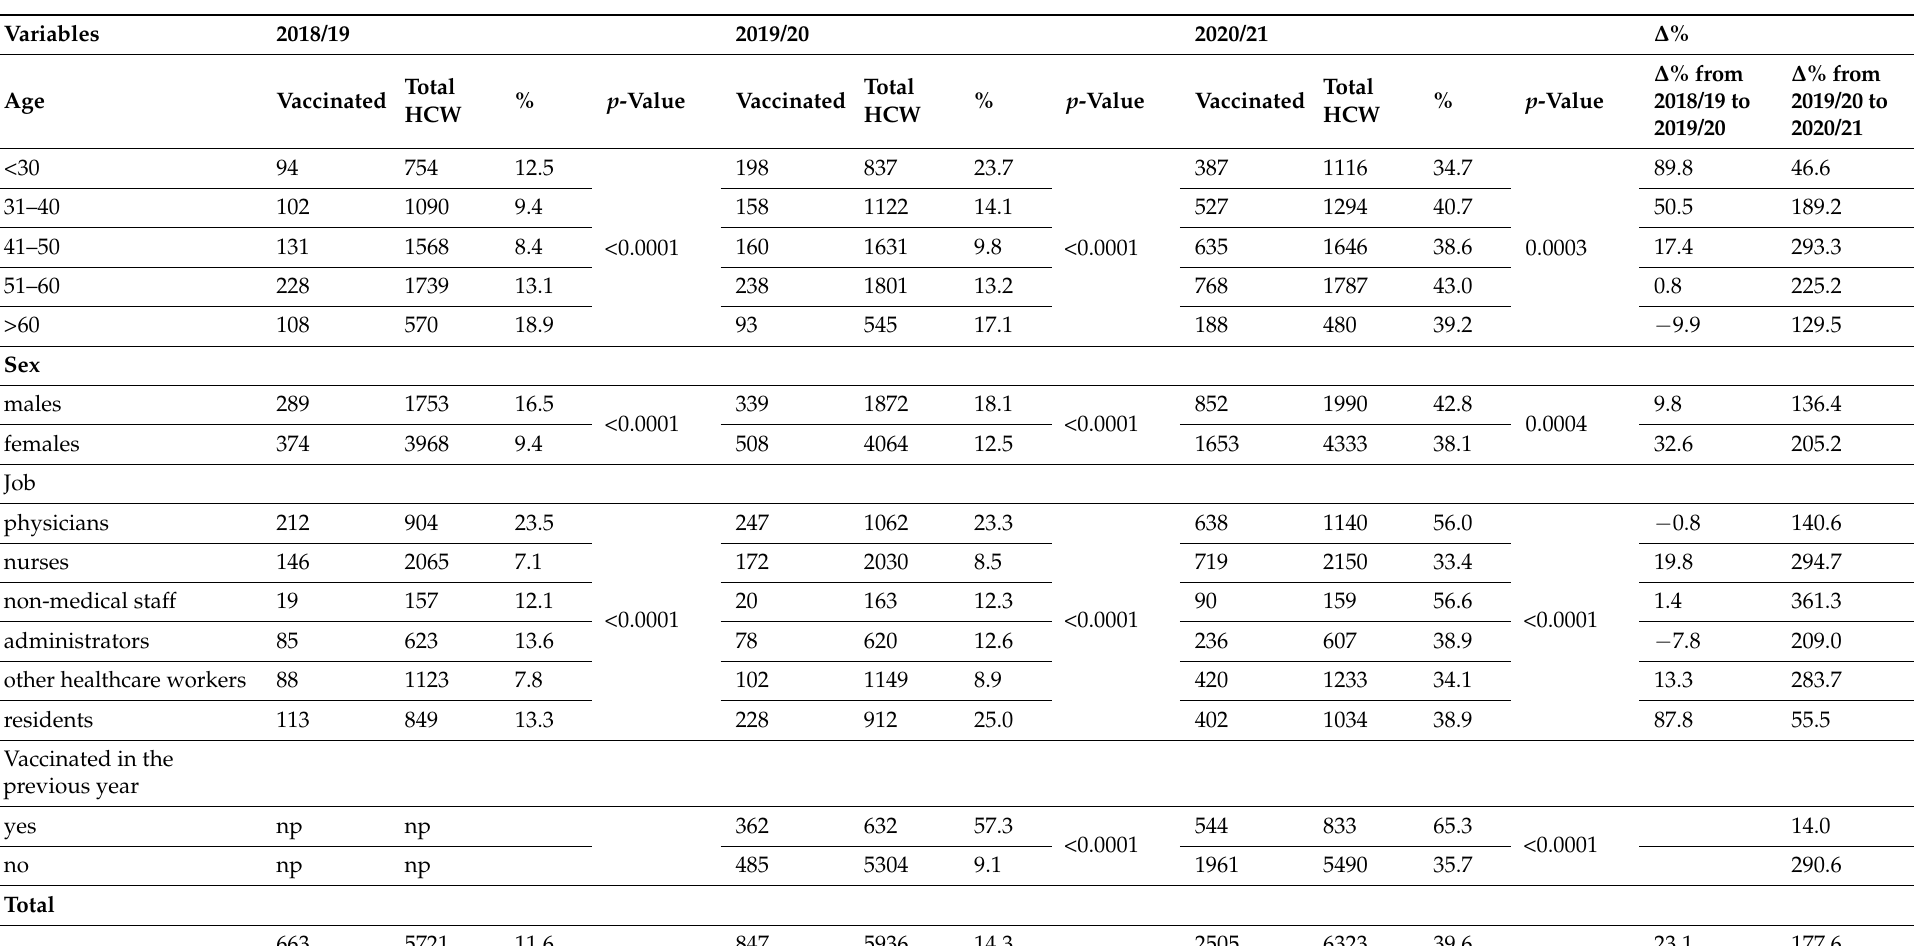
Table 2. Descriptive analysis results of vaccinated subgroups of the study population during the 2018/2019, 2019/2020 2020/2021 seasons and vaccine coverage